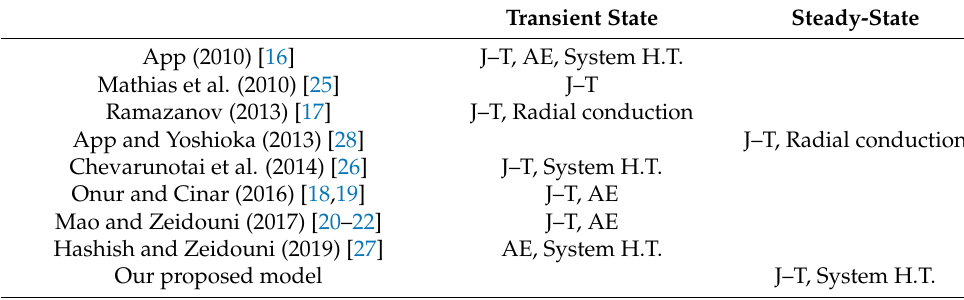
Table 1. Heat transfer mechanism of each model (AE: adiabatic expansion).